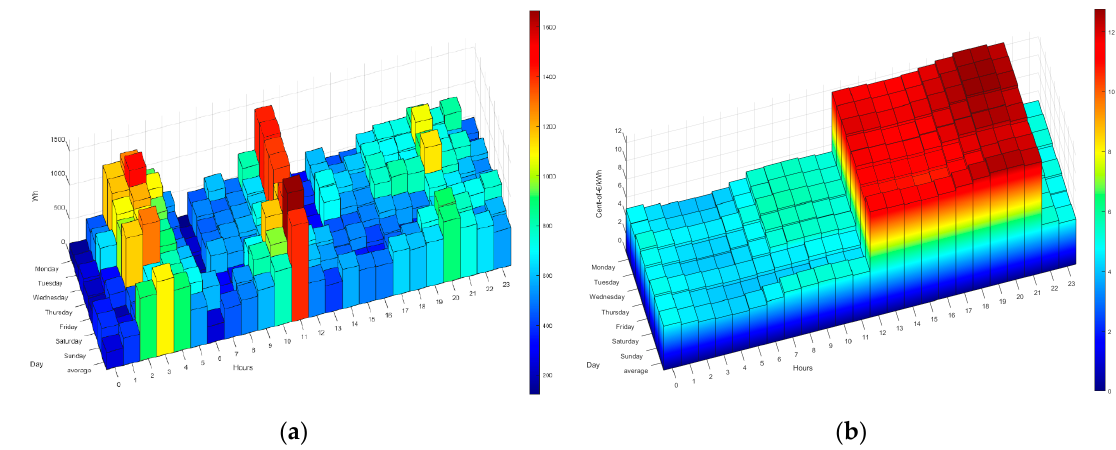
Figure 16. P2. ( a ) Average consumption (Wh) and ( b ) average prices (€ cents per kWh) during the second period (tariff 2.0DHA).